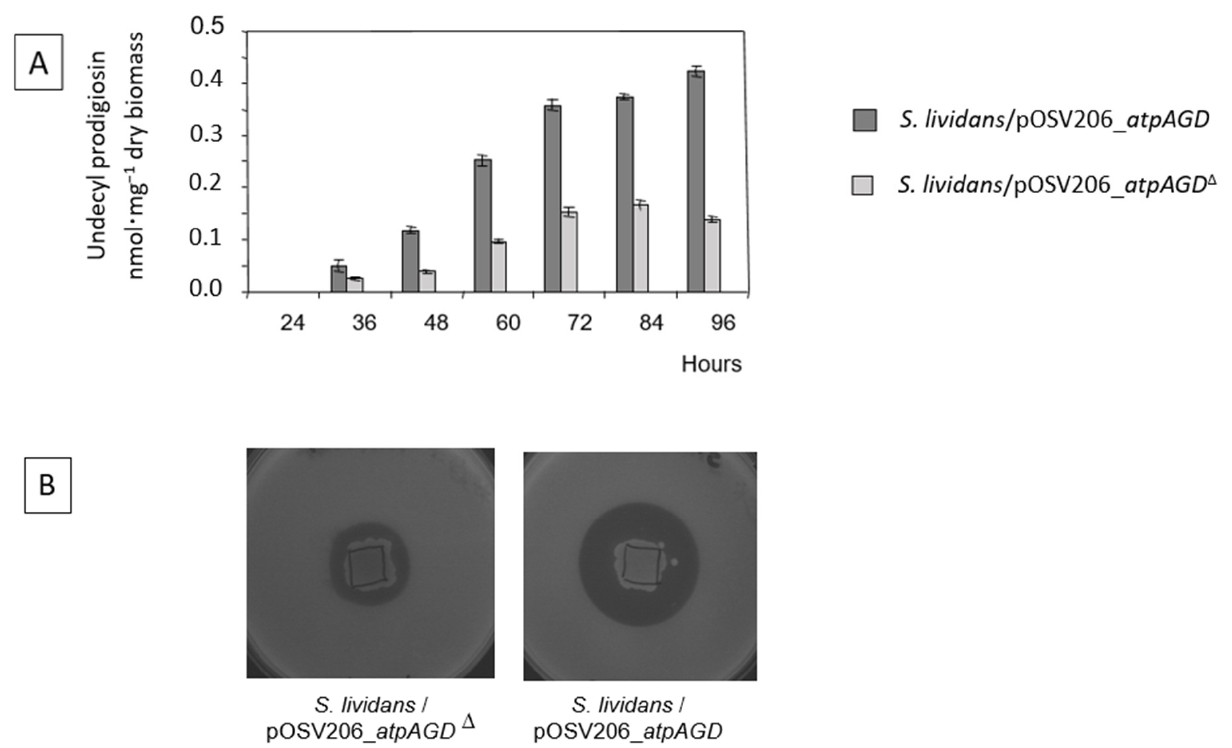
Figure 4. Quantification of undecyprodigiosin (RED) production throughout growth of S. livi- dans /pOSV206_ atpAGD (dark grey histograms) and S. lividans /pOSV206_ atpAGD ∆ (light grey his- tograms) grown for 48 h on solid HT medium ( A ) and detection of CDA production via the formation of halos of inhibition of Micrococcus luteus growth around the deposit of a piece of agar culture of S. lividans /pOSV206_ atpAGD and S. lividans /pOSV206_ atpAGD ∆ grown on ONA medium for 48 h in presence of calcium ( B ).